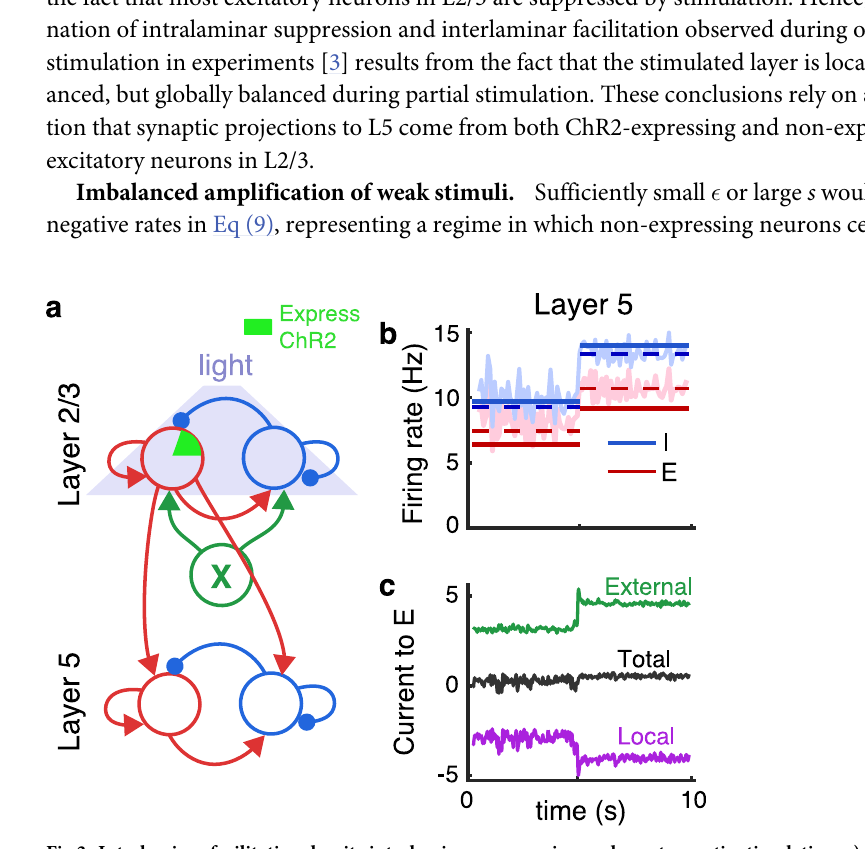
Fig 3. Interlaminar facilitation despite intralaminar suppression under optogenetic stimulation. a) Multi-layer network schematic. L2/3 was identical to the recurrent network in Fig 2 and provided external excitatory input to L5, which had the same internal structure as the L2/3 model. b) Average firing rates of excitatory (red) and inhibitory (blue) neurons in L5 from simulations (light solid) and from the corrected approximation (Eq (4); dashed). c) Mean synaptic currents to 200 randomly selected excitatory neurons in L5 from external inputs ( X ; green), from the local population ( E + I ; purple) and the total synaptic current (black). Currents are measured in units of the neurons’ rheobase (rheobase/ C = 10.5 m